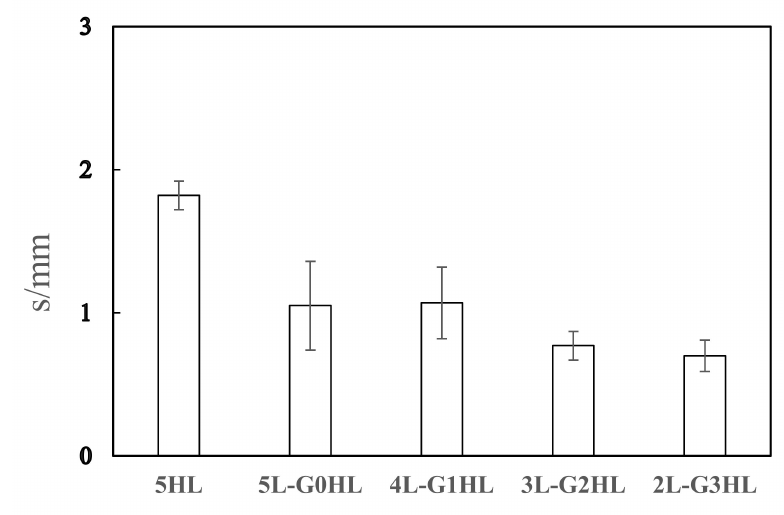
Figure 9. Permeability test of shell mould after sintering at 1125 ◦ C.